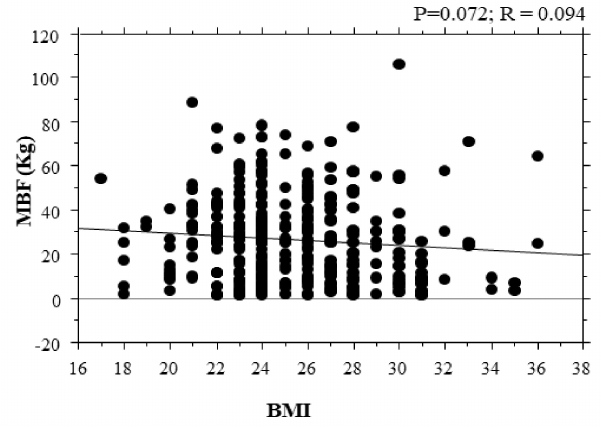
Figure 5. Correction of bite force with BMI. Correlations of maximal bite force with body mass index. MBF: maximal bite force; BMI: body mass index; R= coefficient of correlation; P = p -value ( p